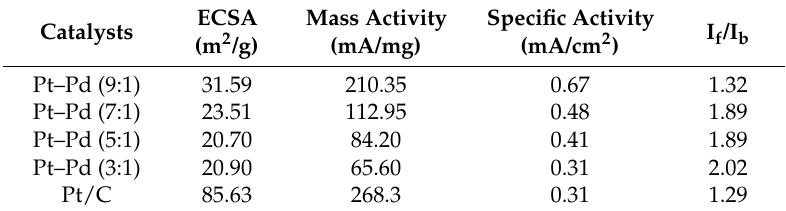
Table 2. The catalytic properties of Pt–Pd nanoparticles prepared by adding precursors with different ratios and commercial Pt/C for methanol oxidation